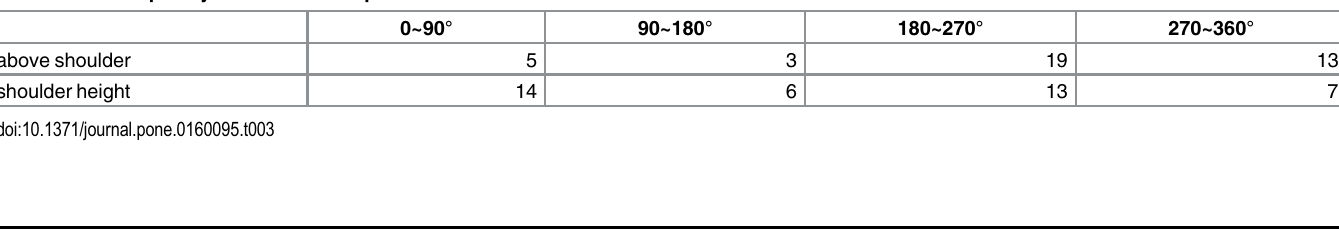
Table 3. The frequency of mean trials reproduced in the four areas.